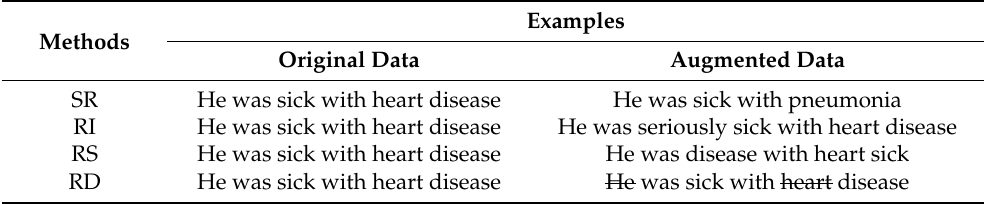
Table 1. The EDA of four text data augmentation methods.